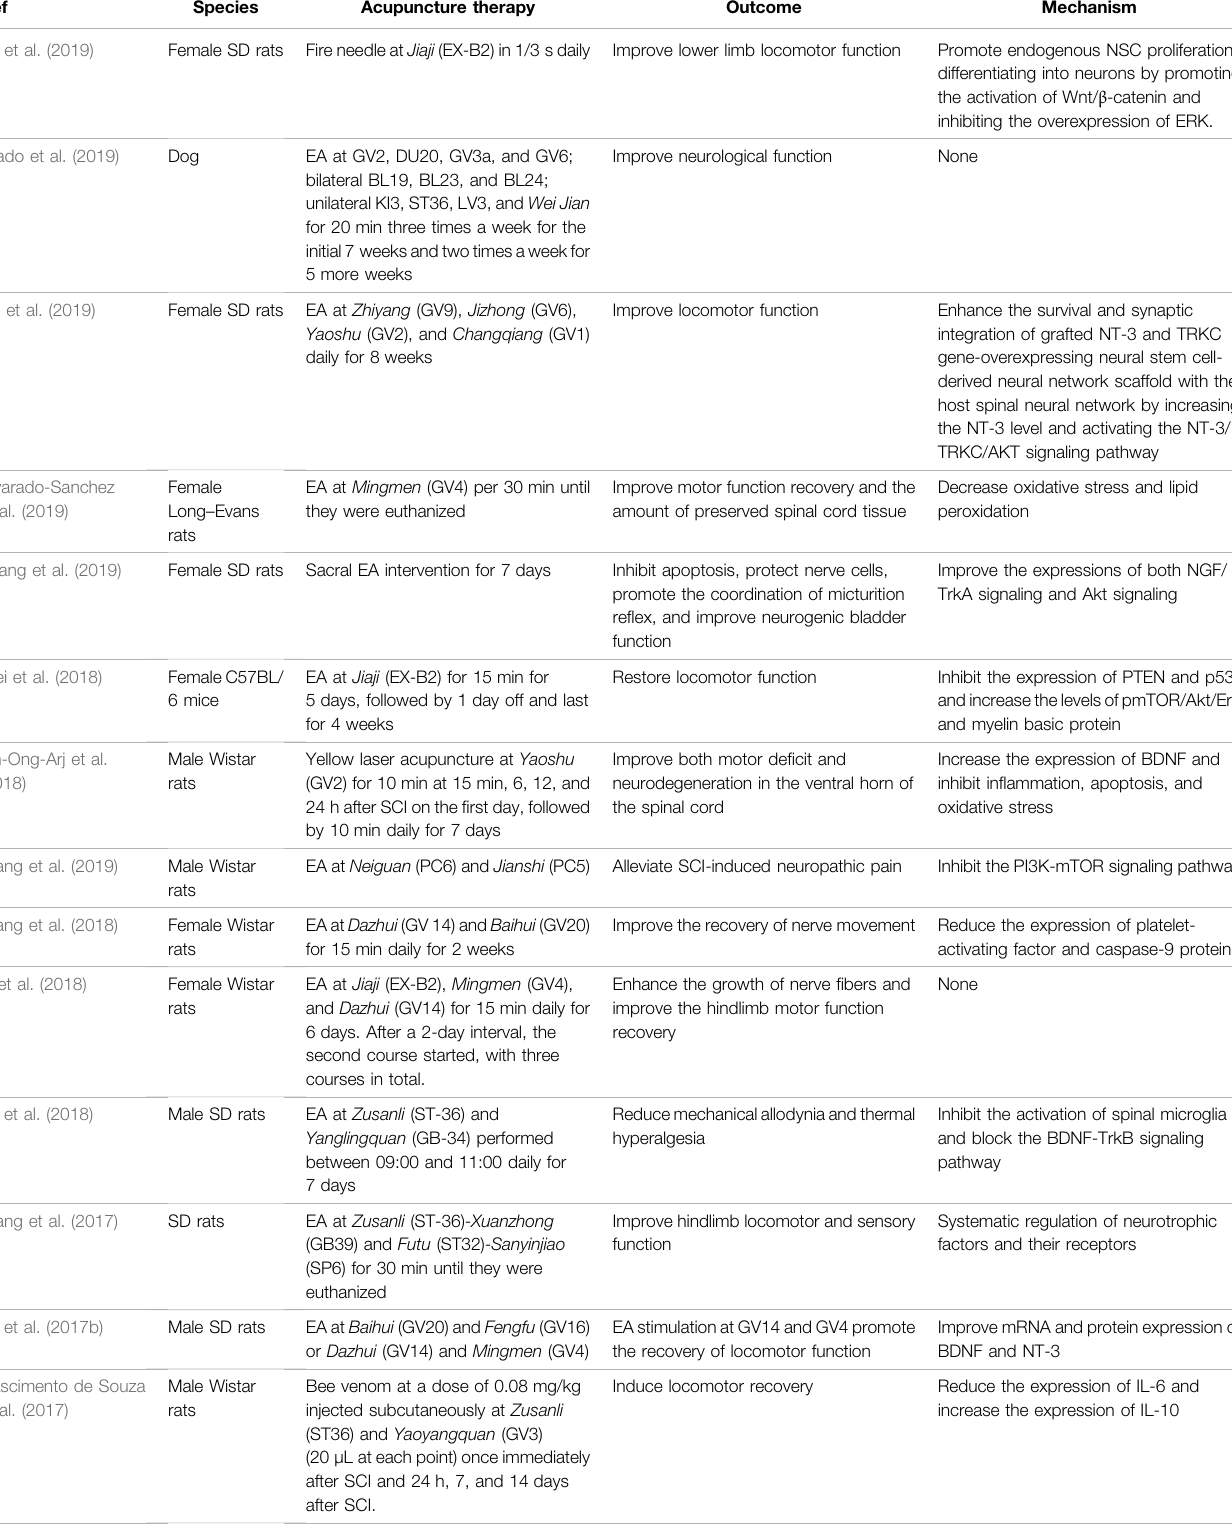
TABLE 1 | ( Continued ) Summary of preclinical studies of acupuncture therapy in spinal cord injury in recent 5